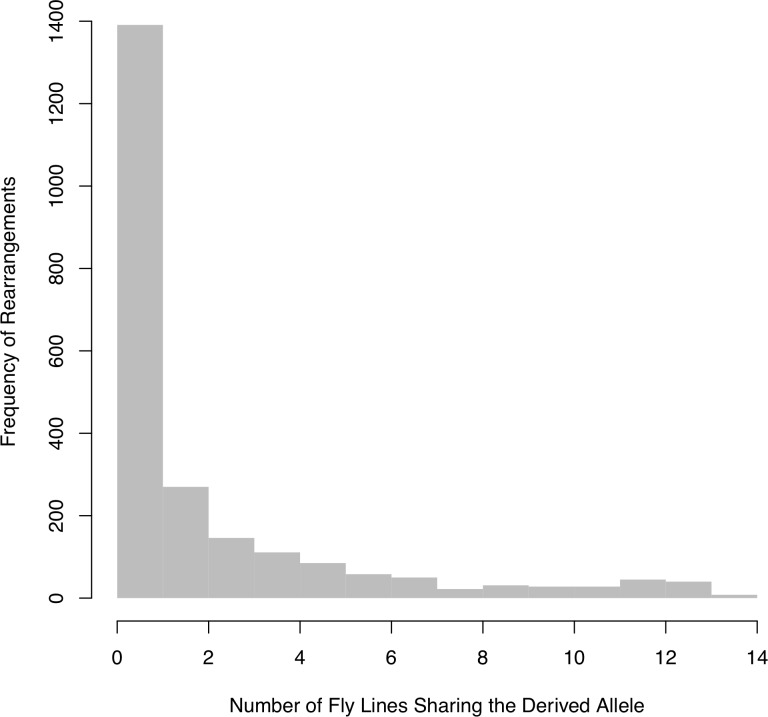
Site frequency spectrum of rearrangements found in the 14 lines.Most of the rearrangements are singletons. However, there is a slight increase in number of rearrangements found in at least 11 of the 14 lines.